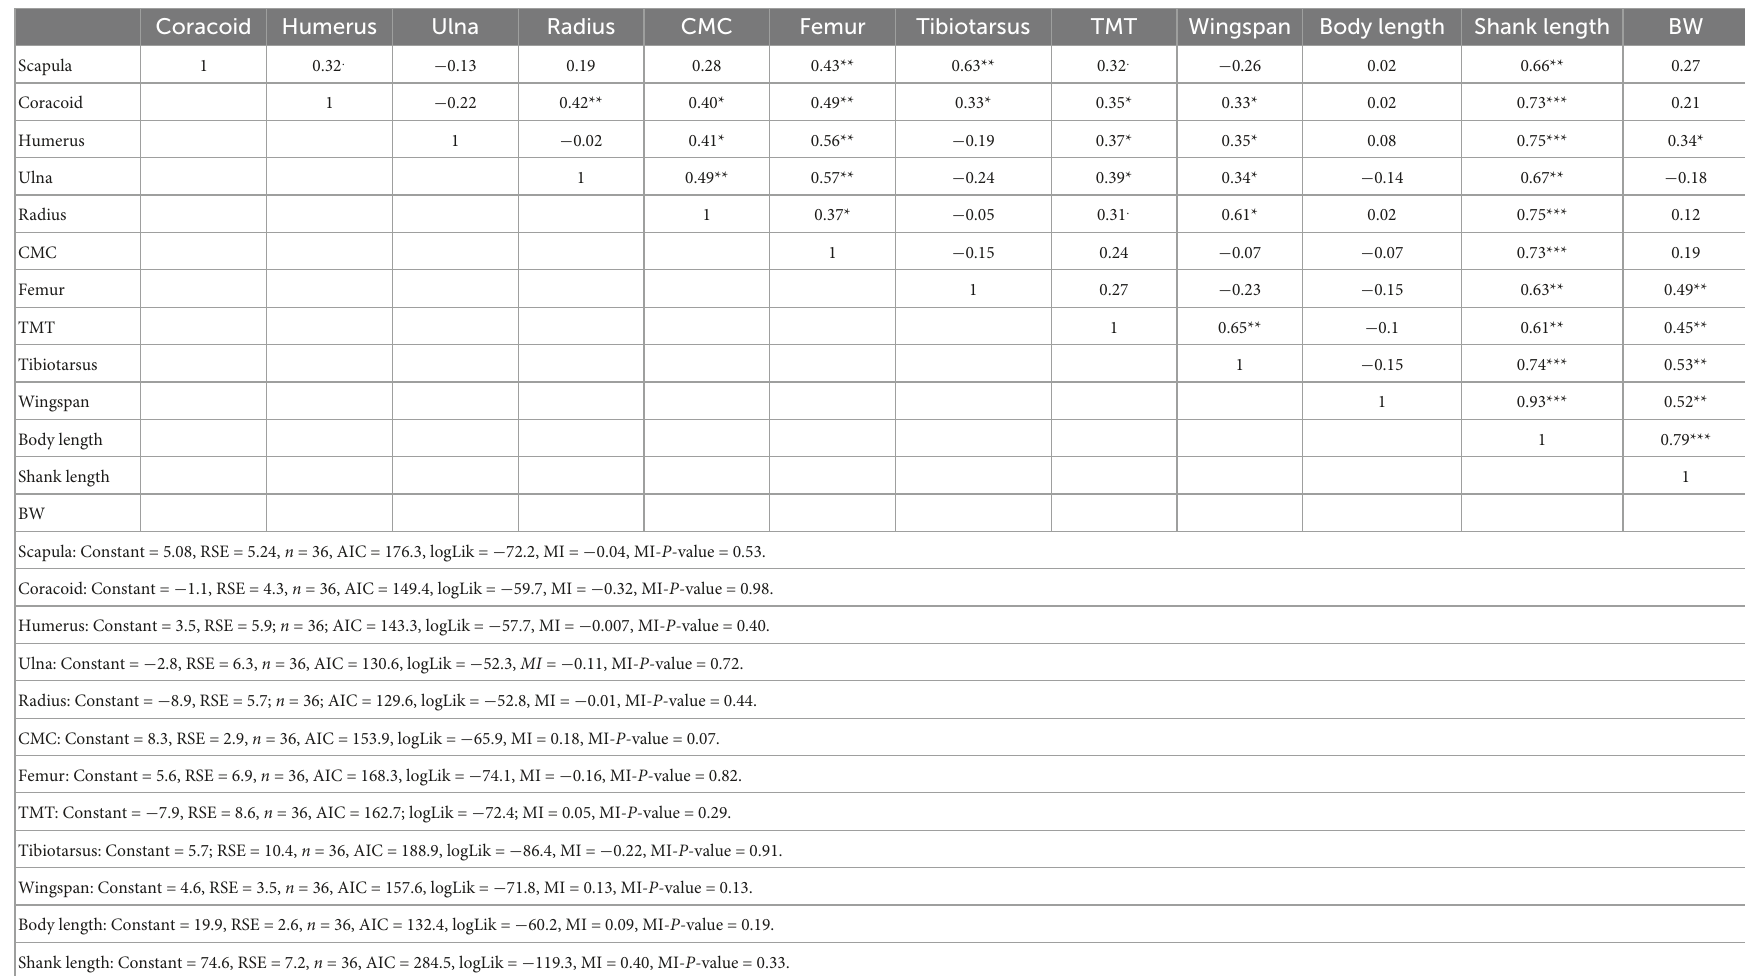
TABLE 1 Relationships (multiple linear regression) between morphological and osteological variables. Coracoid